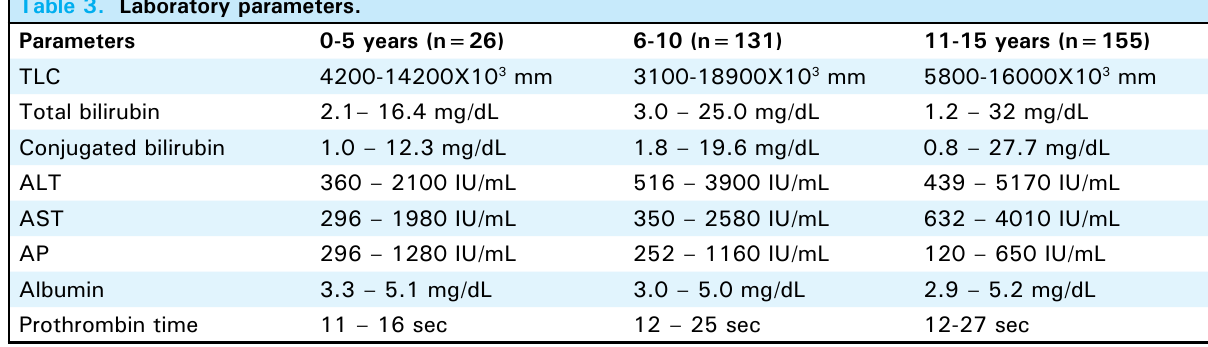
table 3. Laboratory parameters.